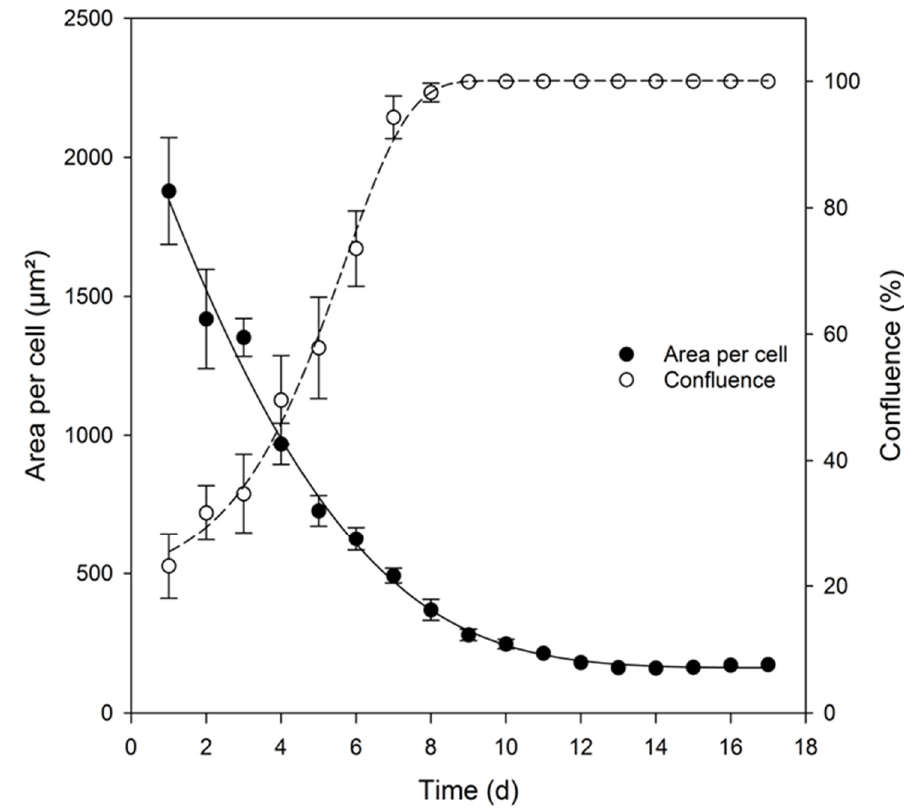
Figure 7. Relationship between confluence and the area of an SH-SY5Y cell over a cultivation period of 17 days. The cell area was determined by the bright field live-cell analyzer JuLI Br. (Regression coefficient for confluency: r 2 = 0.9982; for the cell area: r 2 = 0.9848.)